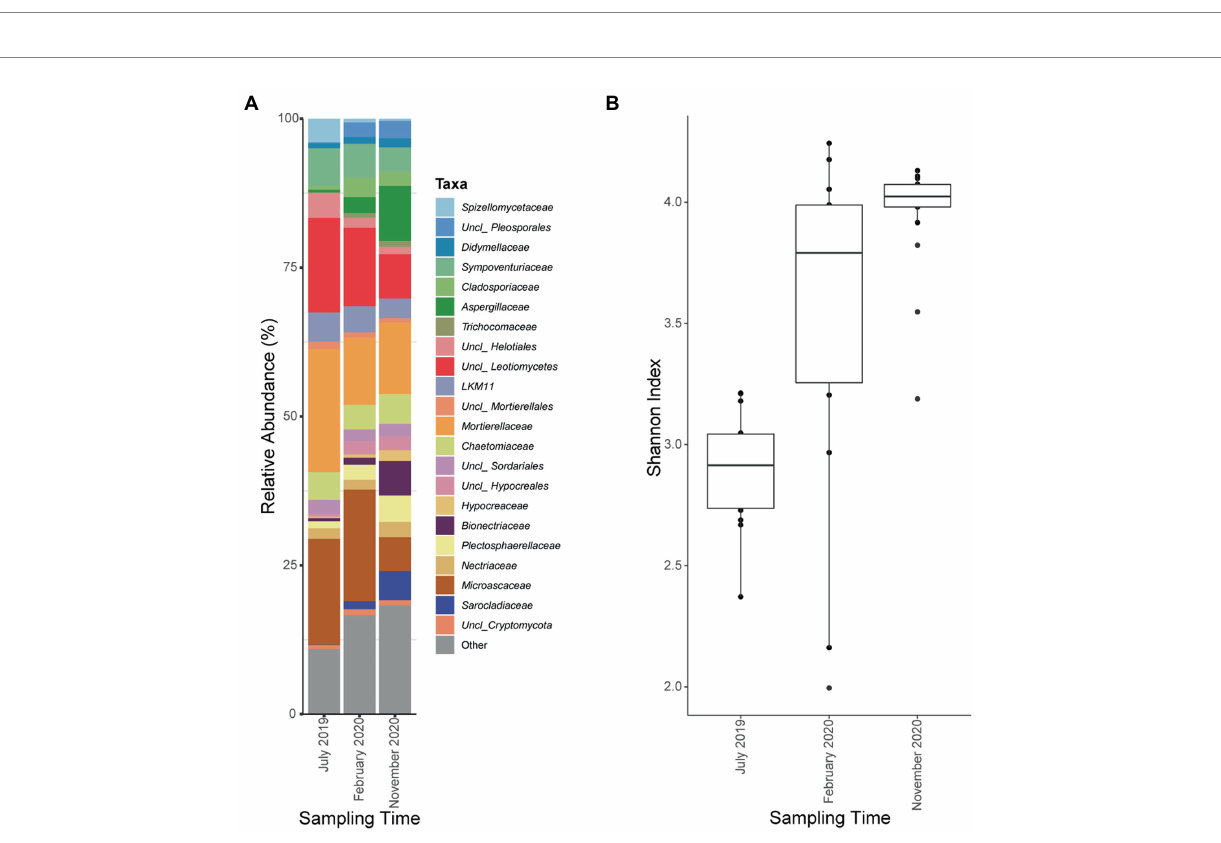
FIGURE 6 Fungal relative abundances at the level of class and family and Shannon indexes of Ecopiles at the three sampling times. (A) Relative ASVs abundance at the level of class of the Ecopiles at each of the timepoints. Low abundance taxa were grouped under the category Other. The barplots represent the average of ASVs from Ecopiles. (B) Evolution of Shannon alpha-diversity indexes within Ecopiles along sampling